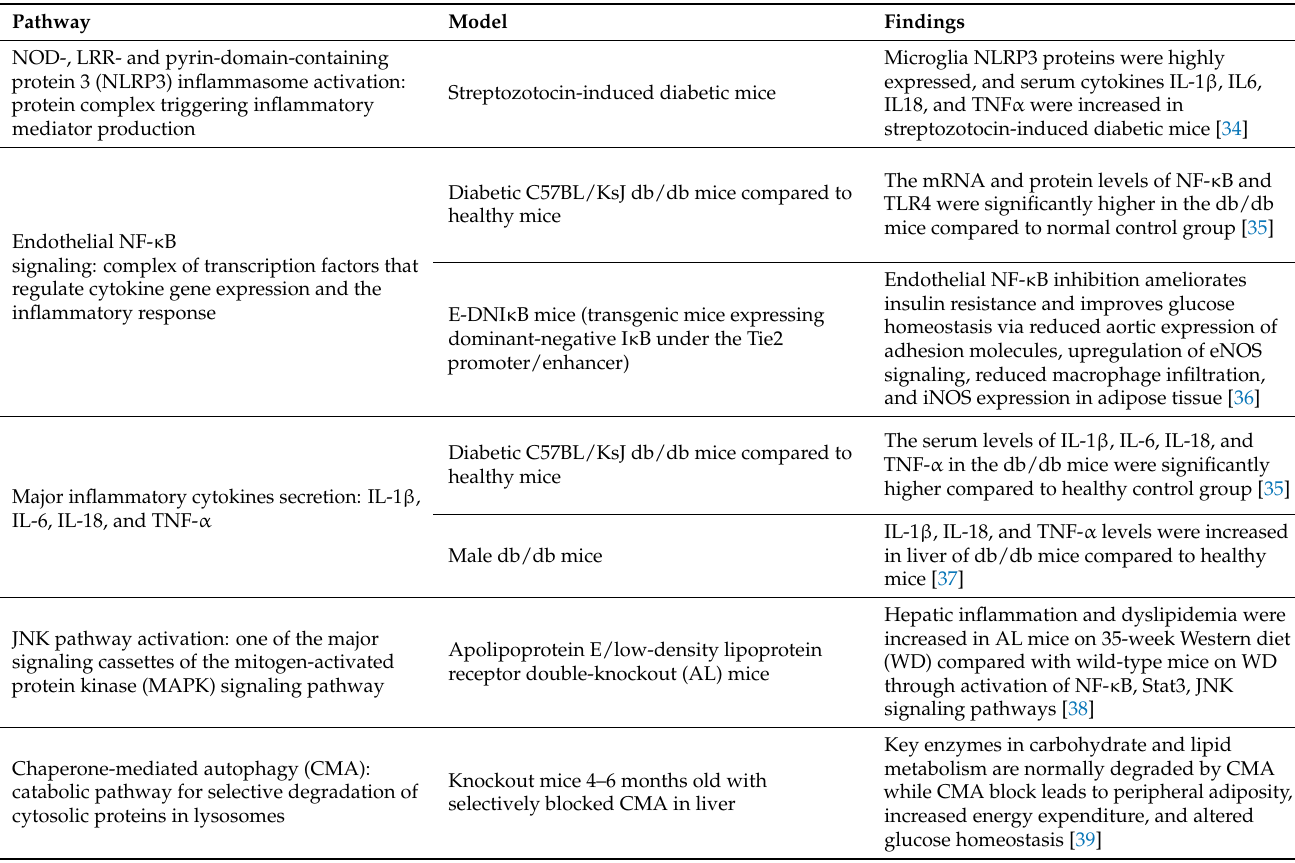
Table 1. Some key inflammatory pathways of diabetes proven in